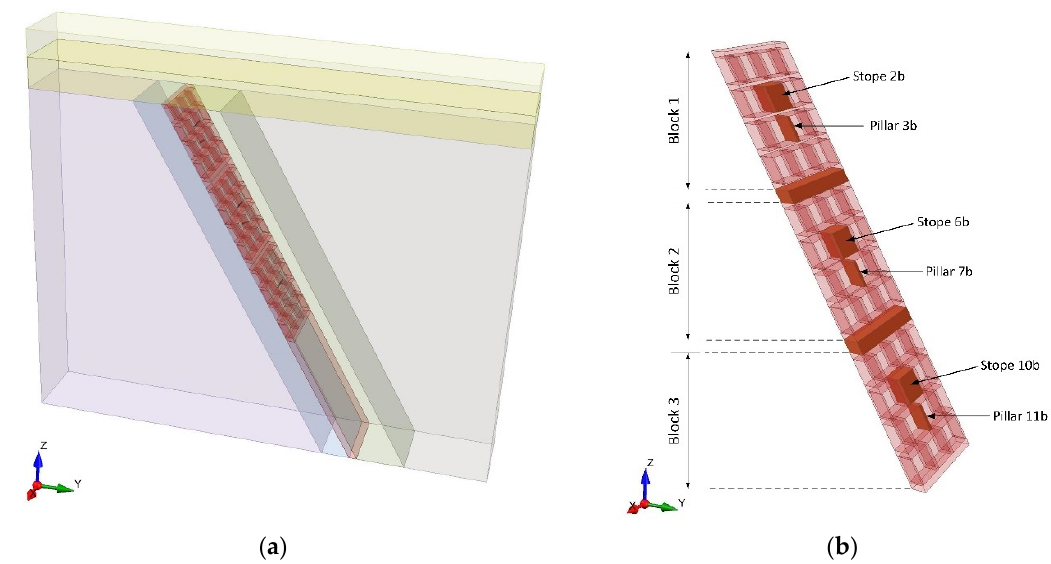
Figure 2. ( a ) The numerical model for the three mining blocks in the SLOS method. ( b ) The stopes and rib pillars under investigation in each mining block.